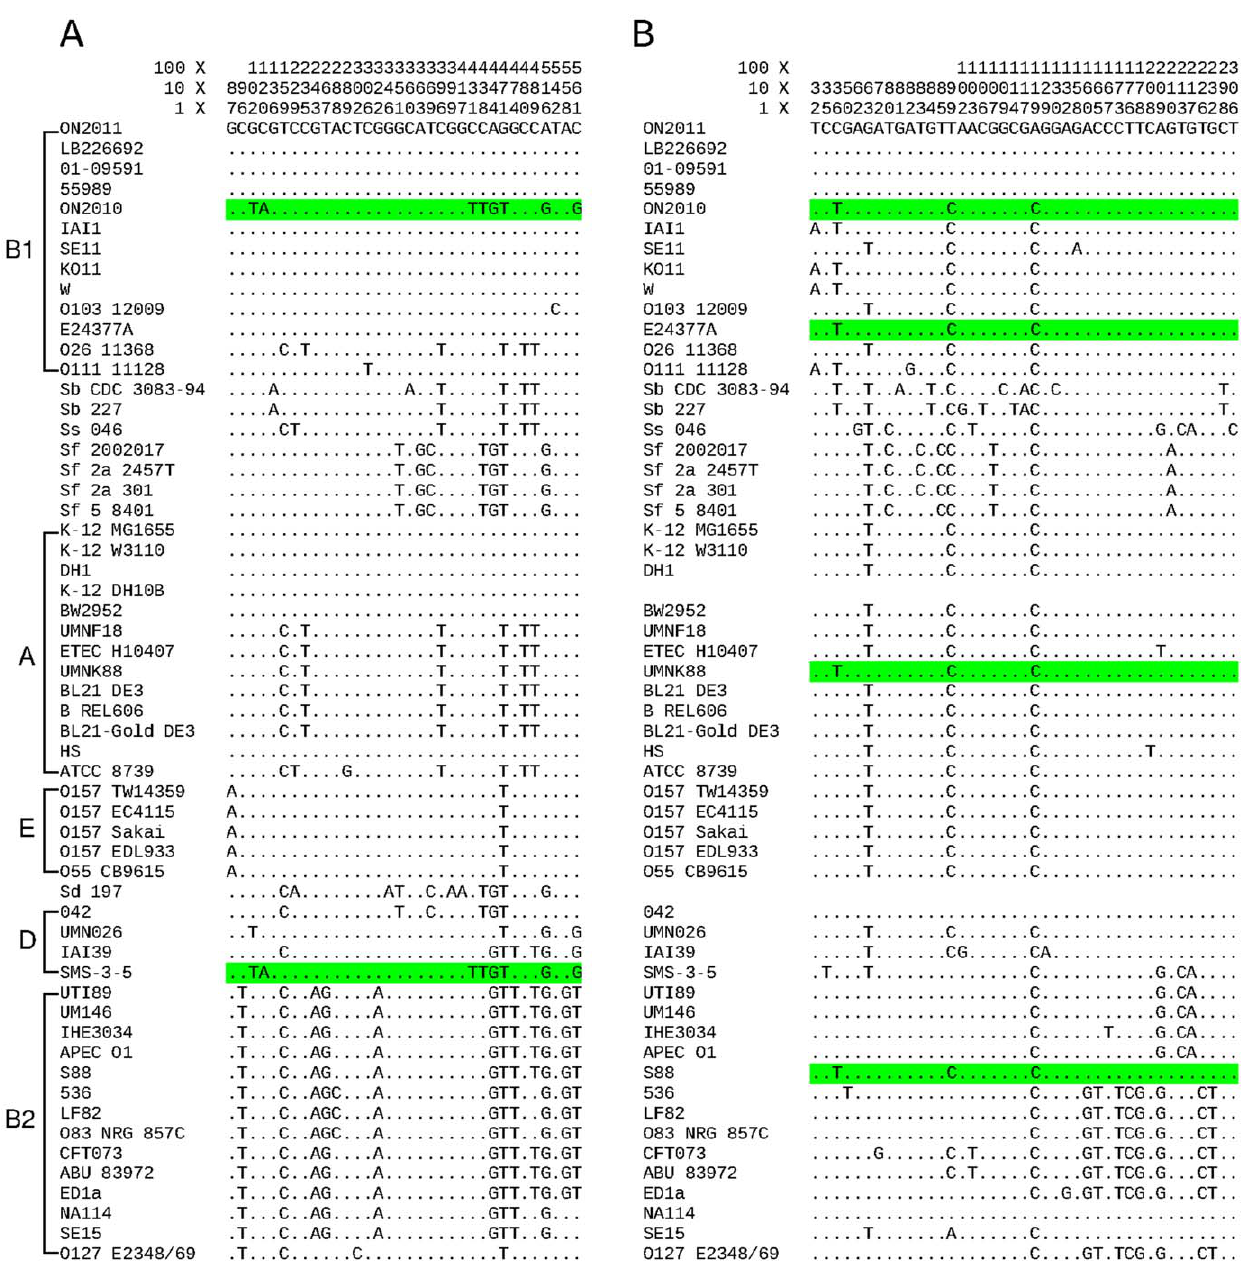
Figure 9. Sequence alignments of yaaH (A) and EC55989_4986 (B). Only informative sites are shown with coordinates at the top. Sequences that are identical with the ON2010 sequence are highlighted in light